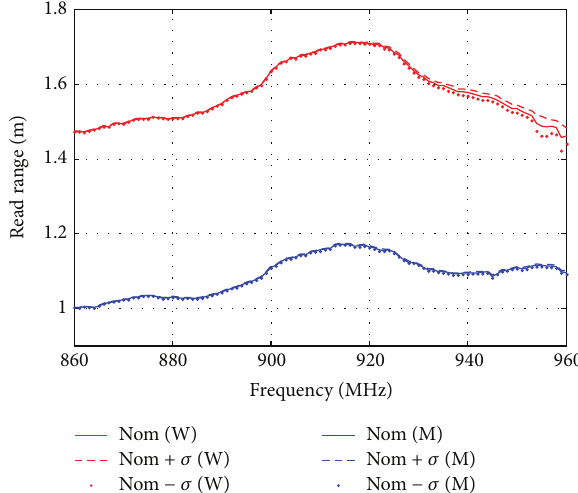
Figure 9: Reference response measurement results ( 𝐸 -plane) for the head case for woman (W) and man (M). The measurements are based on 20 repetitive threshold power measurements.